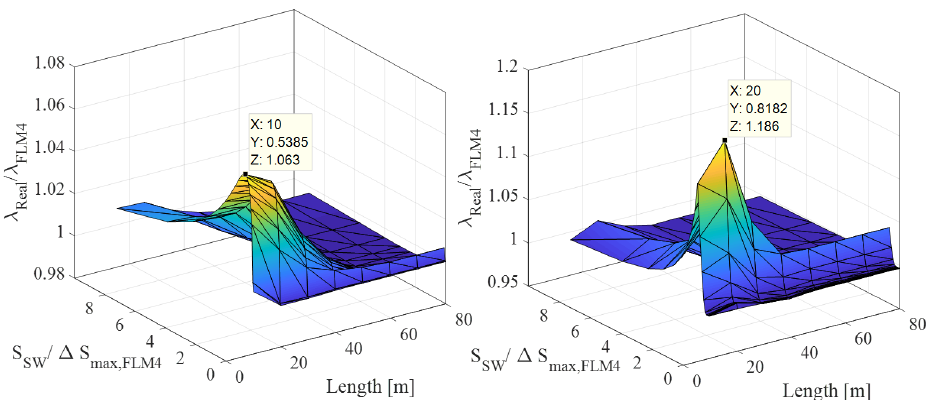
Figure 11. The ratio of λ HFMI for original real traffic in Sweden and λ HFMI for FLM3 calculated for the mid-span section (to the left ) and mid-support section (to the right ).